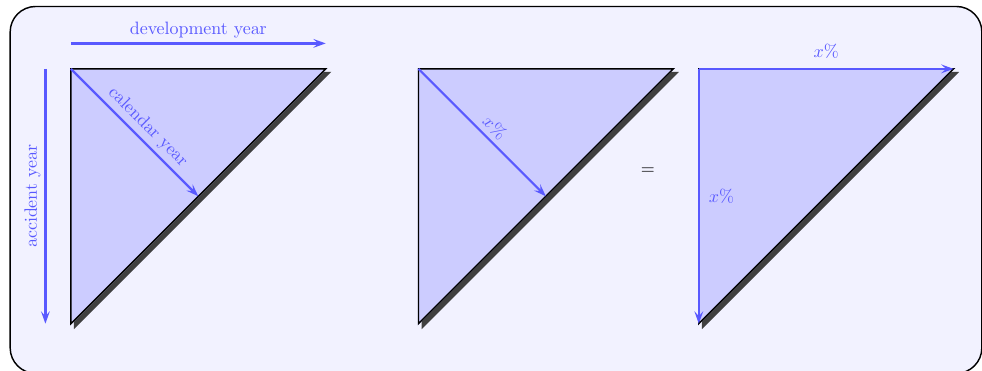
Figure 12. Trend properties of claims development